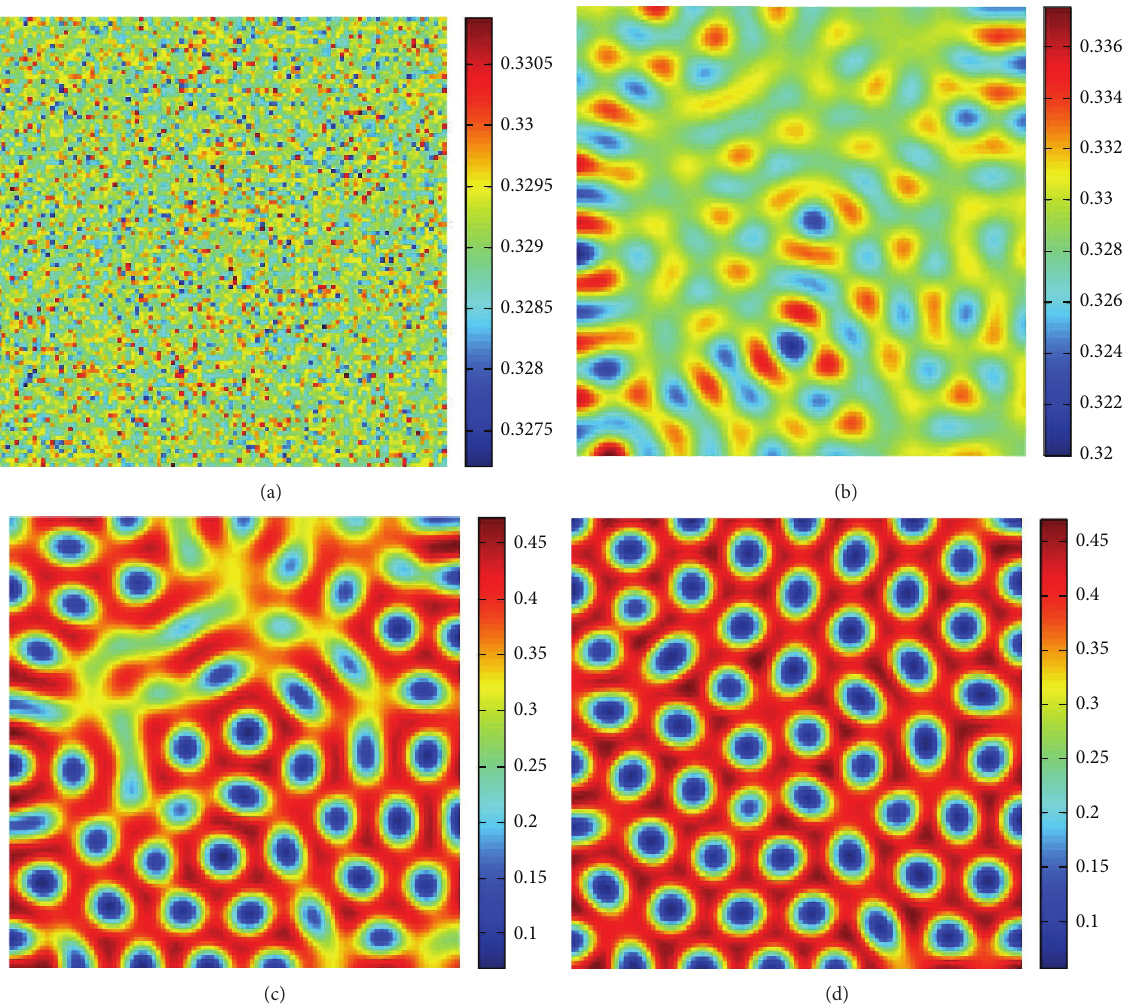
Figure 1: Typical Turing patterns of 𝑢 in model (7) with parameters 𝛼 = 1 , 𝛽 = 0.3 , 𝛾 = 0.3 , 𝑏 = 0.5 , 𝑐 = 0.6 , 𝑚 = 0.6 , 𝑞 = 0.35 , 𝑠 = 1.75 , = 0.015 , and 𝑑 = 1 . Times: (a) 0; (b) 50; (c) 250; (d) 𝑑 1 2